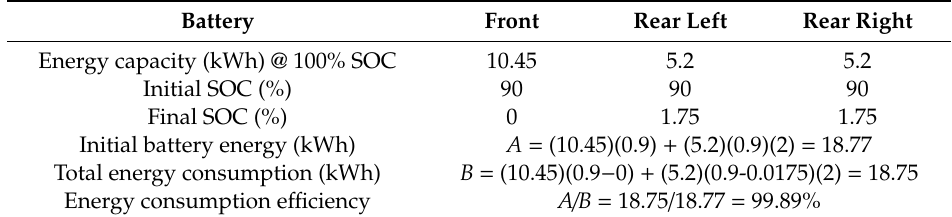
Table 4. Energy consumption e ffi ciency for the EV on a straight road of UDC by the TBD strategy. Battery Front Rear Left Rear